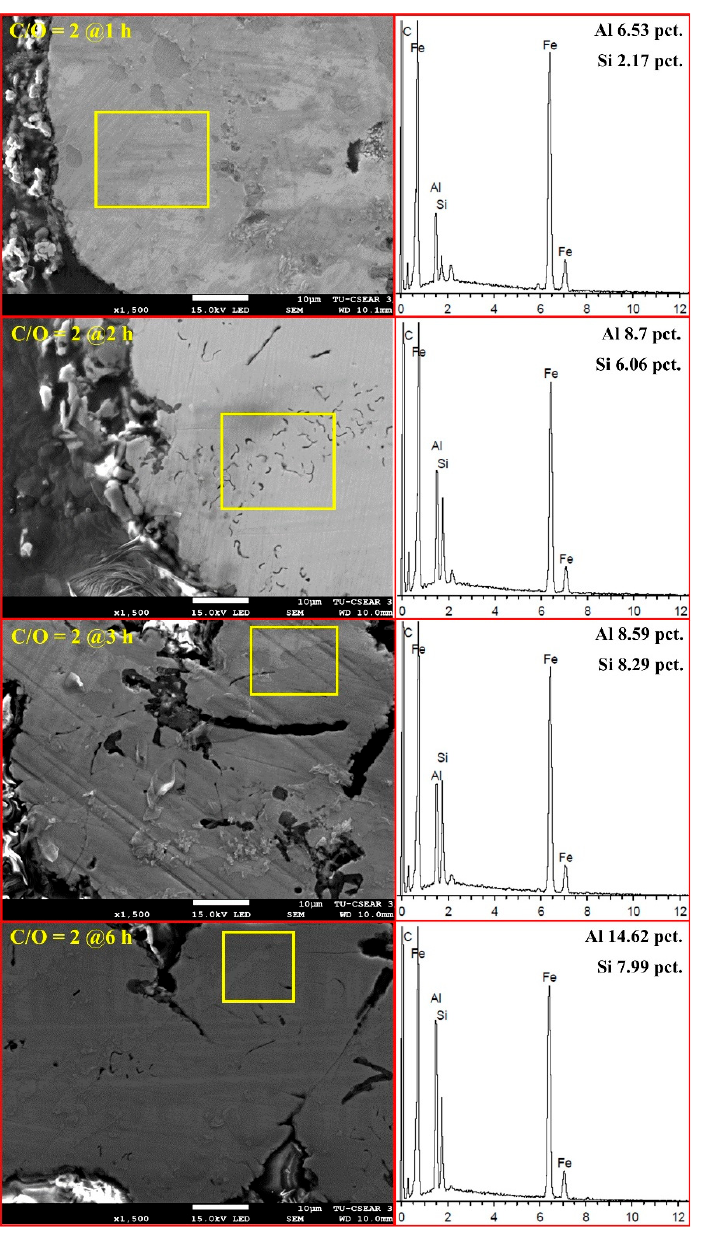
Figure 11. Comparison of SEM micrograph and EDS spectra of the cross-sectioned pellet (C/O = 2) after heating at 1550 °C for 1, 2, 3, and 6 h. Table 5. Composition of the synthesis metals for the sample (C/O = 2).